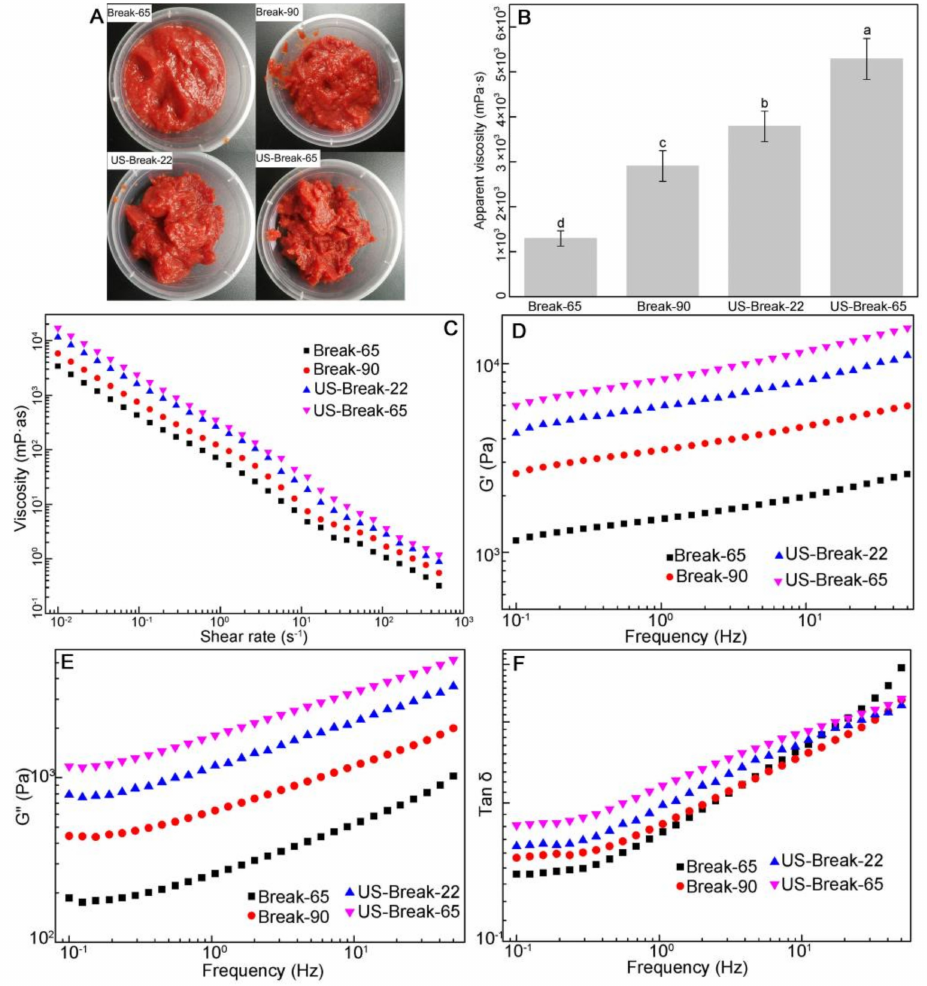
Figure 4. Effects of different breaking treatments on the appearance ( A ), viscosity ( B ), flow behavior ( C ), the dynamic rheological properties ( D – F ) of tomato paste. Break-65, Break-90, US-Break-22 and US-Break-65 refer to the thermal break at 65 ◦ C for 10 min, thermal break at 90 ◦ C for 10 min, ultrasound break at 22 ◦ C for 10 min, and ultrasound break at 65 ◦ C for 10 min, respectively a–d Data bearing different lowercase letters were significantly different ( p <